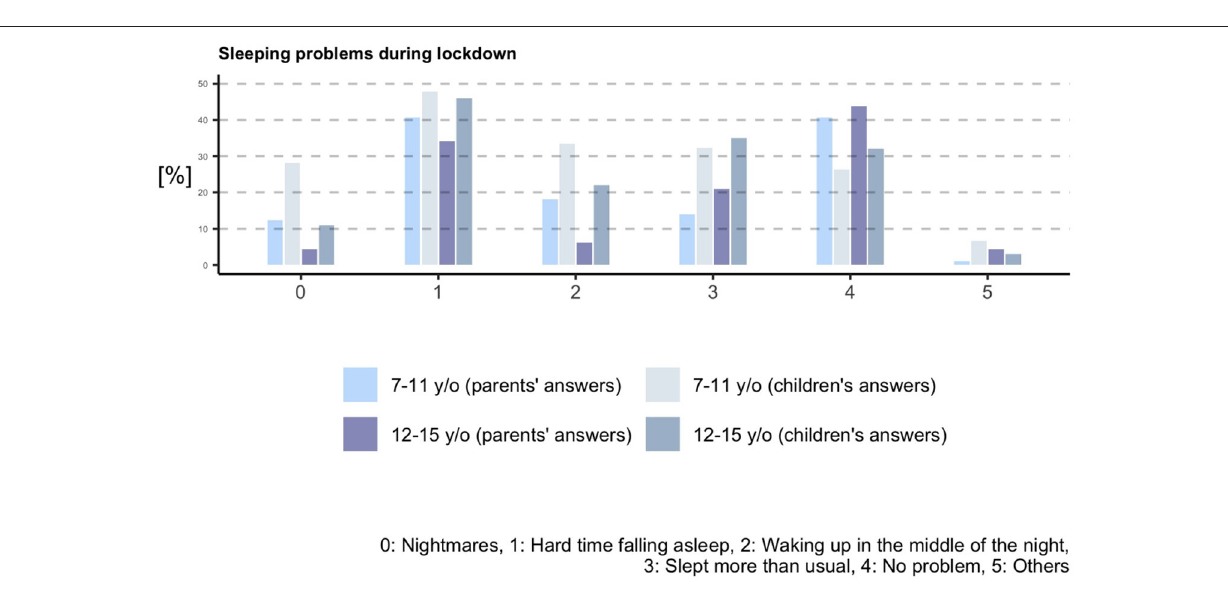
FIGURE 3 | Sleeping problems during lockdown according to parents and to children and